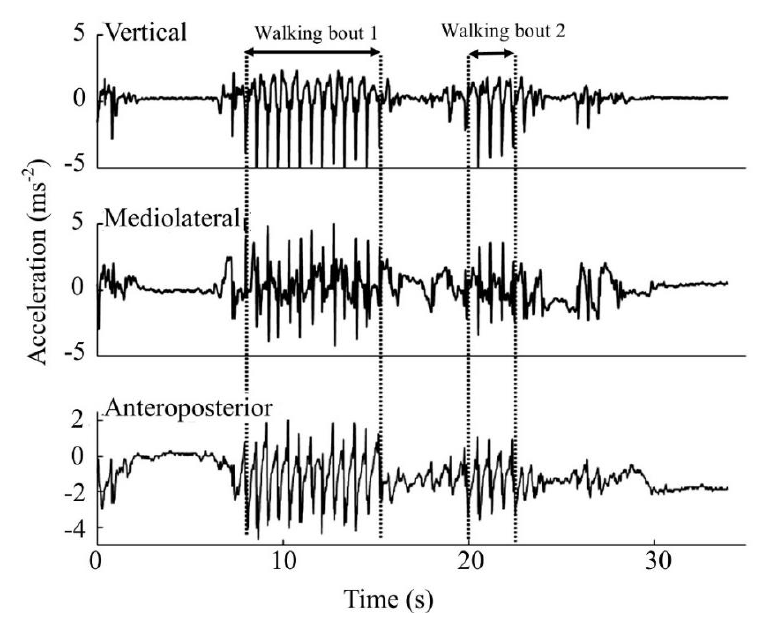
Figure 2. Output data of a body worn monitor for one participant showing vertical, mediolateral, and anteroposterior acceleration. A longer walking bout 1 and shorter walking bout 2 are indicated.